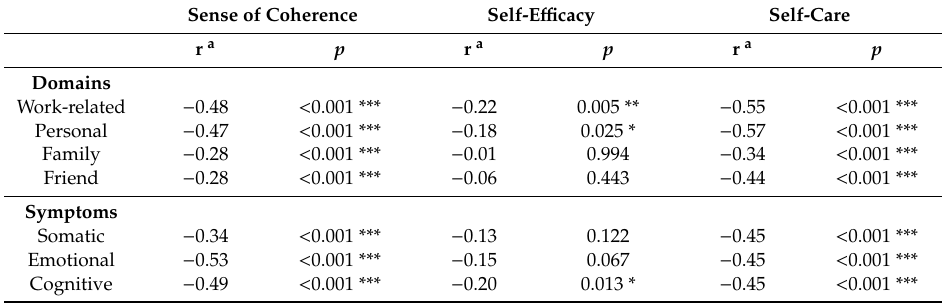
Table 3. Associations between burnout symptoms in di ff erent life domains and sense of coherence, self-e ffi cacy and self-care.